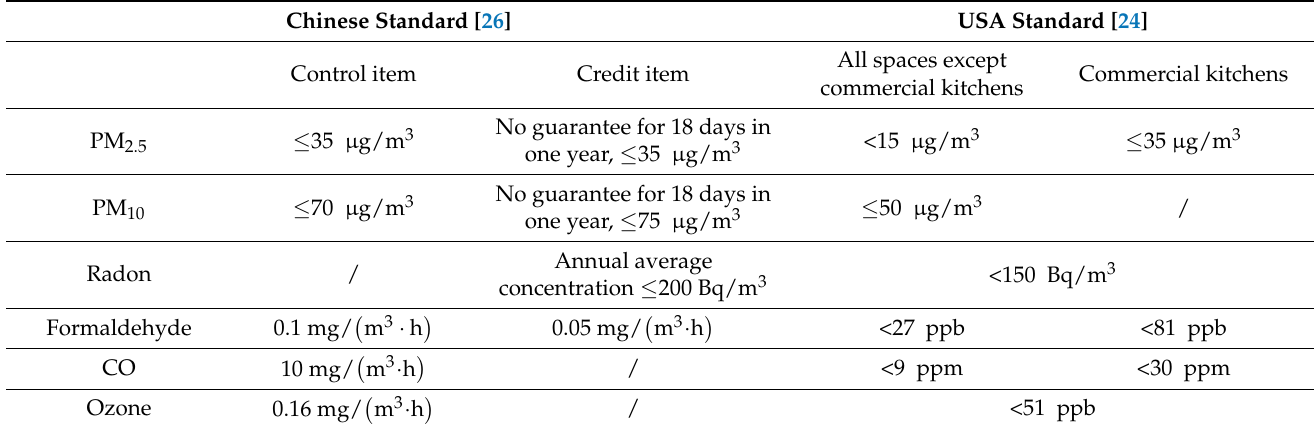
Table 2. Comparison of indoor air quality requirements for healthy buildings standards in China and